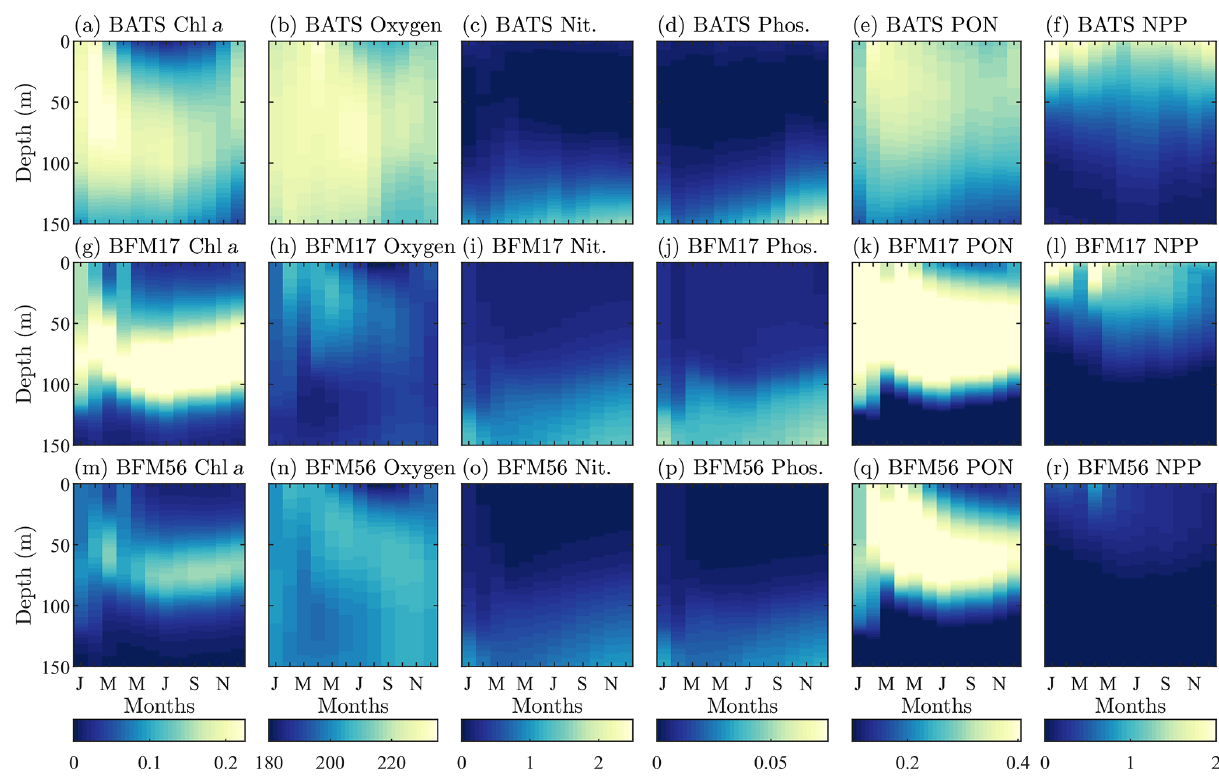
Figure 4. Comparison of target BATS fields (a–f) to BFM17 simulation results (g–l) and BFM56 simulation results (m–r) for (a ,g, m) chloro- phyll (mgChl a m − 3 ), (b, h, n) oxygen (mmolOm − 3 ), (c, i, o) nitrate (mmolNm − 3 ), (d, j, p) phosphate (mmolPm − 3 ), (e, k, q) particulate organic nitrogen (PON; mgNm − 3 ), (f, l, r) and net primary production (NPP; mgCm − 3 d − 1 ). Simulation plots are multi-year monthly averages of the last 3 years of a 10-year